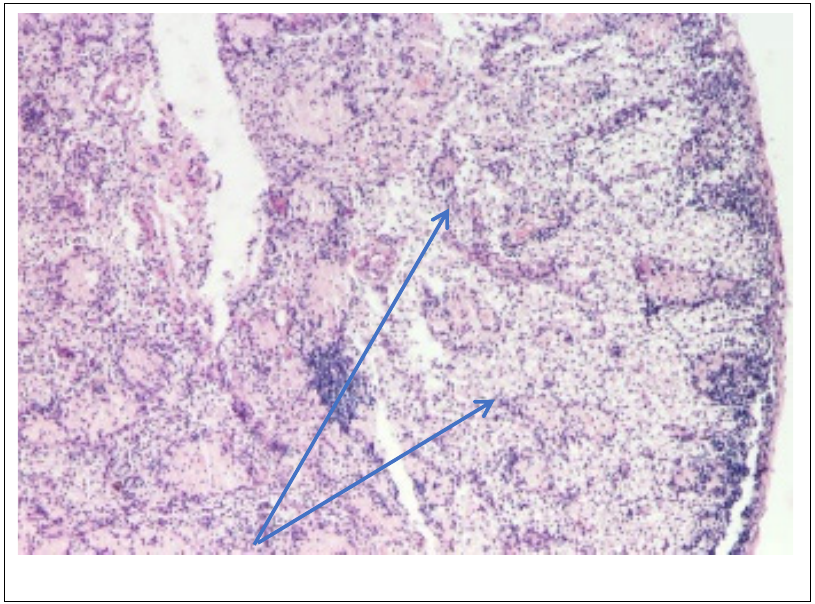
Figure 11. Mesenteric ganglion biopsy ( PAS staining × 100)—Lymph node with obliterated architecture (blue arrow).